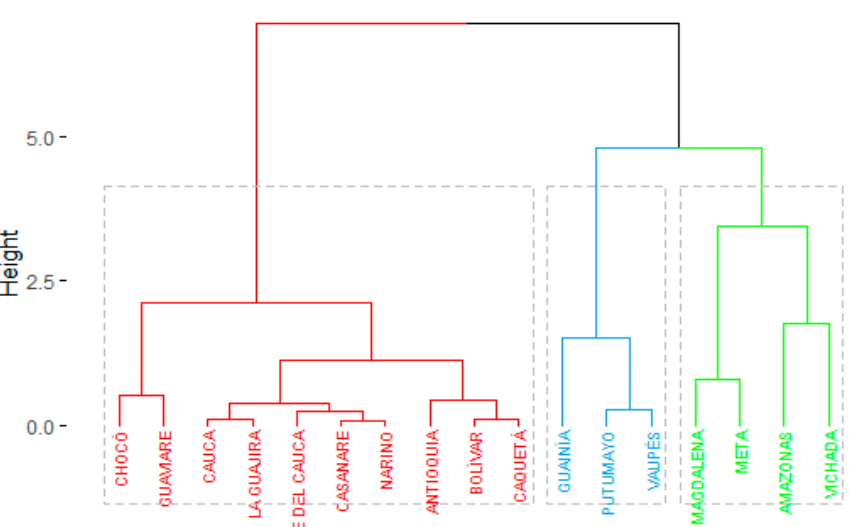
Figure 5. Dendrogram by DIANA algorithm (shire counties, active energy, operating hours and power).